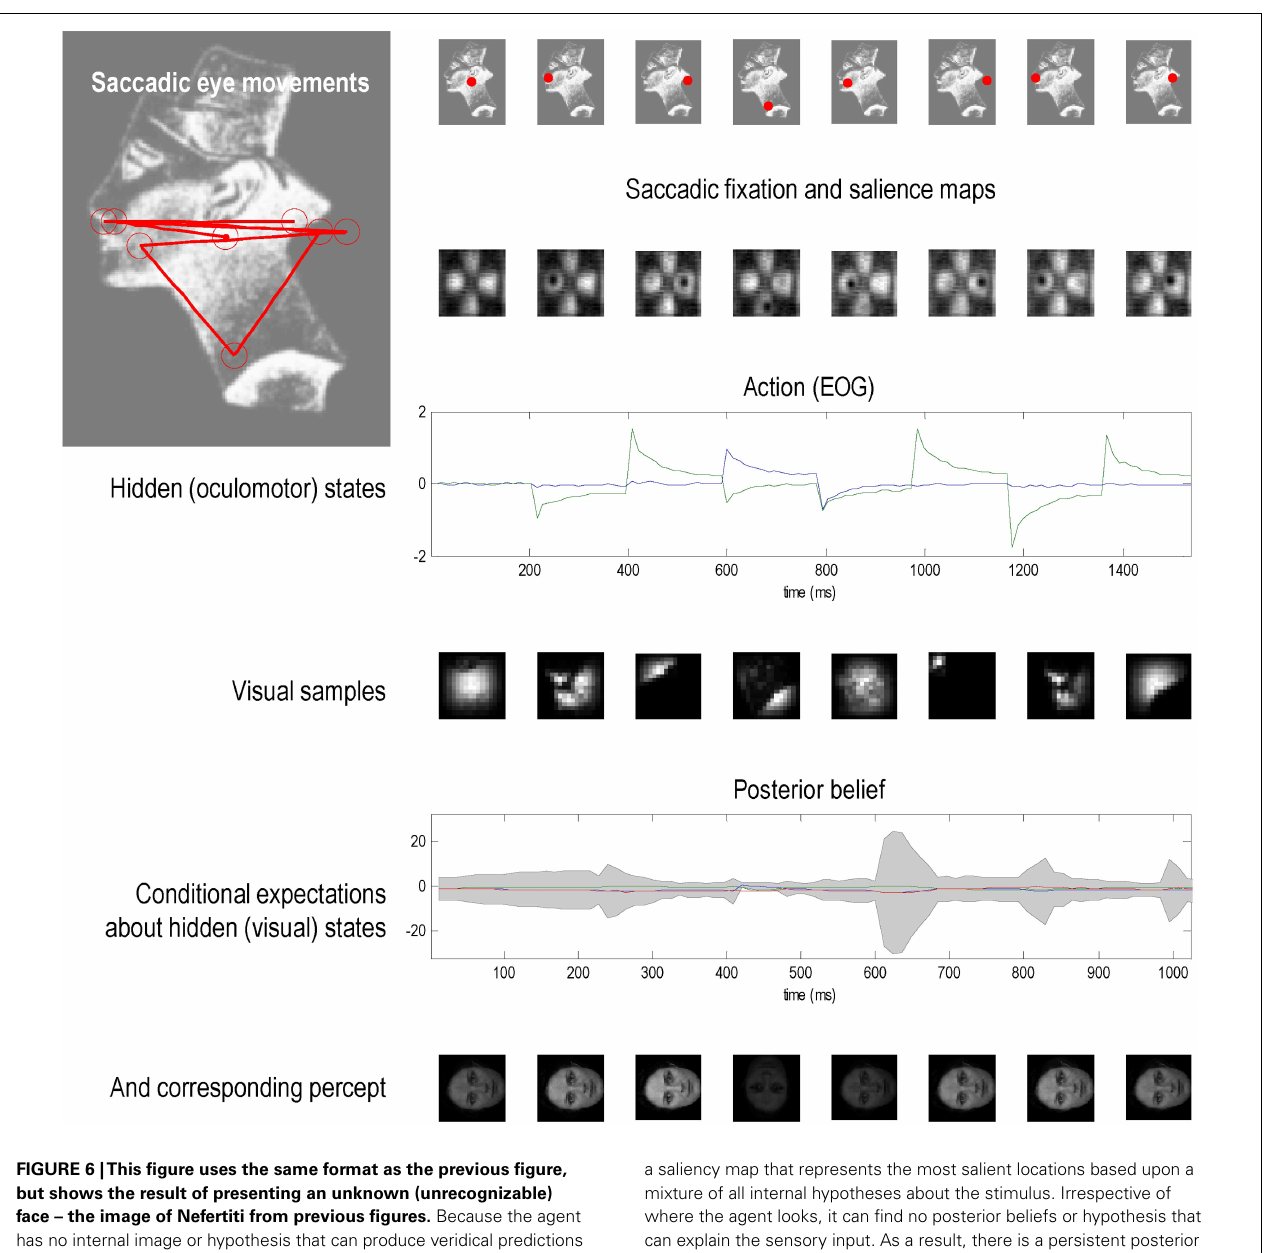
FIGURE 6 |This figure uses the same format as the previous figure, but shows the result of presenting an unknown (unrecognizable) face – the image of Nefertiti from previous figures. Because the agent has no internal image or hypothesis that can produce veridical predictions about salient locations to foveate, it cannot resolve the causes of its sensory input and is unable to assimilate visual information into a precise posterior belief about the stimulus. Saccadic movements are generated by